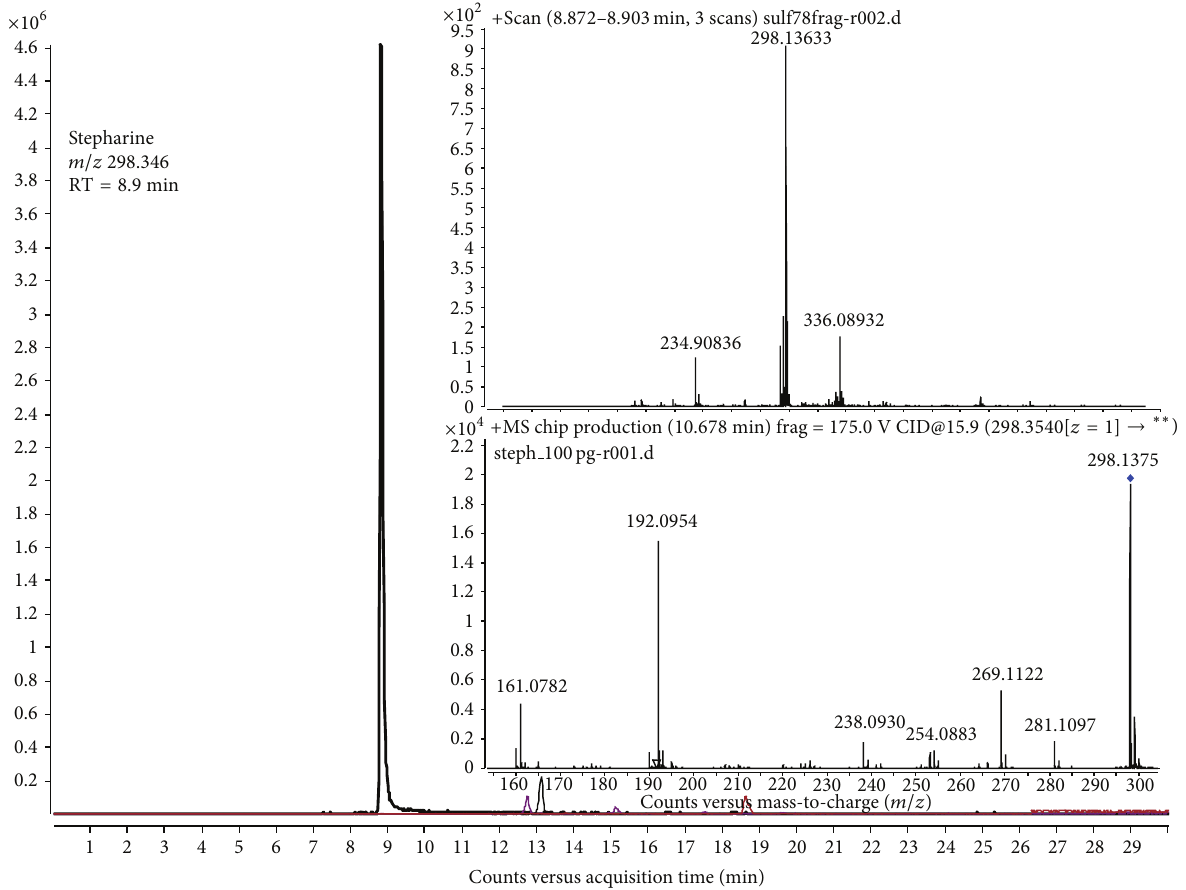
Figure 2: Extracted ion chromatography of stepharine ( 𝑚/𝑧 = 298.346 , retention time 8.9 minutes) precursor registered on high resolution Q-TOF mass